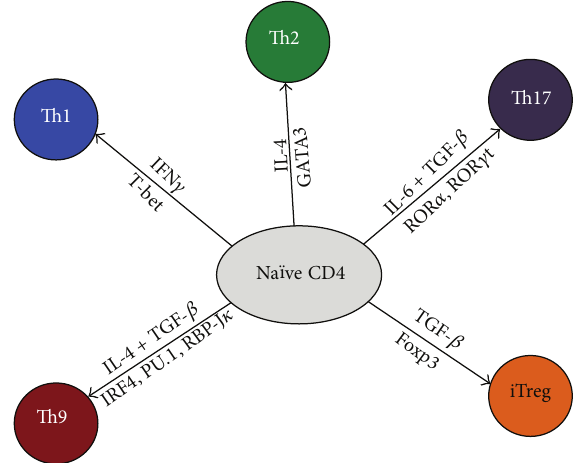
Figure 2: Schematic illustration of CD4 + T cell differentiation into effector or regulatory T cells. Depending on the cytokine milieu (shown above the arrows) present at the time of the initial engagement of their TCR, naive CD4 + T cells can differentiate into various subsets of T-helper cells (Th1, Th2, Th9, and Th17). However, in the presence of TGF- 𝛽 1, naive T cells convert into foxp3-expressing induced Treg (iTreg) cells. For each T-helper cell differentiation program, specific transcription factors (shown below the arrows) have been identified as master regulators (T-bet, GATA3 and ROR 𝛾 t) for Th1, Th2, and Th17, respectively. IRF4, PU.1, and RBP-J 𝜅 transcription factors have been shown recently to contribute to the induction to Th9